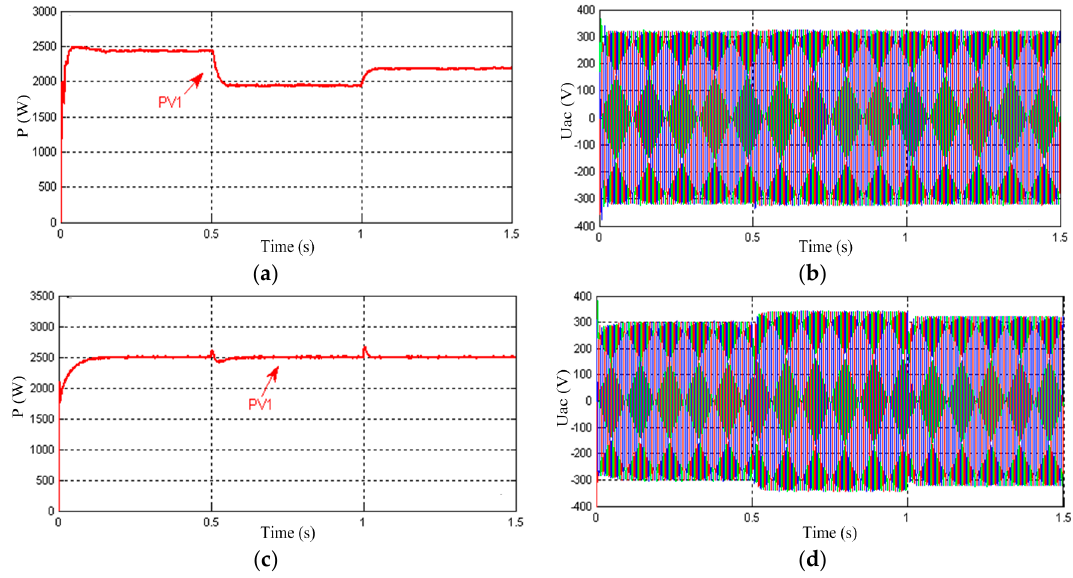
Figure 9. Simulated results of case 1: ( a ) output power without Droop ‐ 1 control; ( b ) AC bus voltage without Droop ‐ 1 control; ( c ) output power with Droop ‐ 1 control; and ( d ) AC bus voltage with Droop ‐ 1 control.